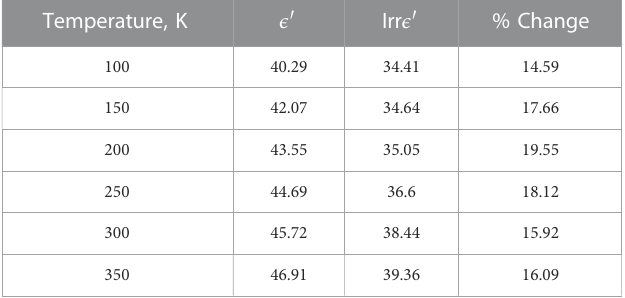
TABLE1Thecomparativedielectricvaluesforpre-andpost-irradiatedsamplesat discrete temperatures and a fi x frequency of 2 MHz. Temperature,